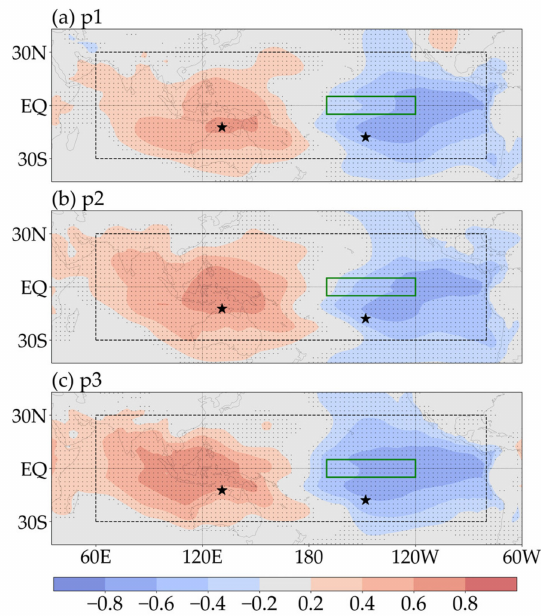
Figure 6. The correlation coefficients (blue-red scale) between Niño-3.4 index series and SLP anomaly field during three periods ( a – c ). The p1, p2, and p3 are the same as in Figure 1. The green box is the Niño-3.4 region. The left and right asterisks in each subfigure show the locations of Darwin and Tahiti stations, respectively. The black dashed box is the main coupling region between Niño-3.4 index and SLP anomalies. Light black dots indicate that the results pass the Student t -test with a confidence level of 95%.